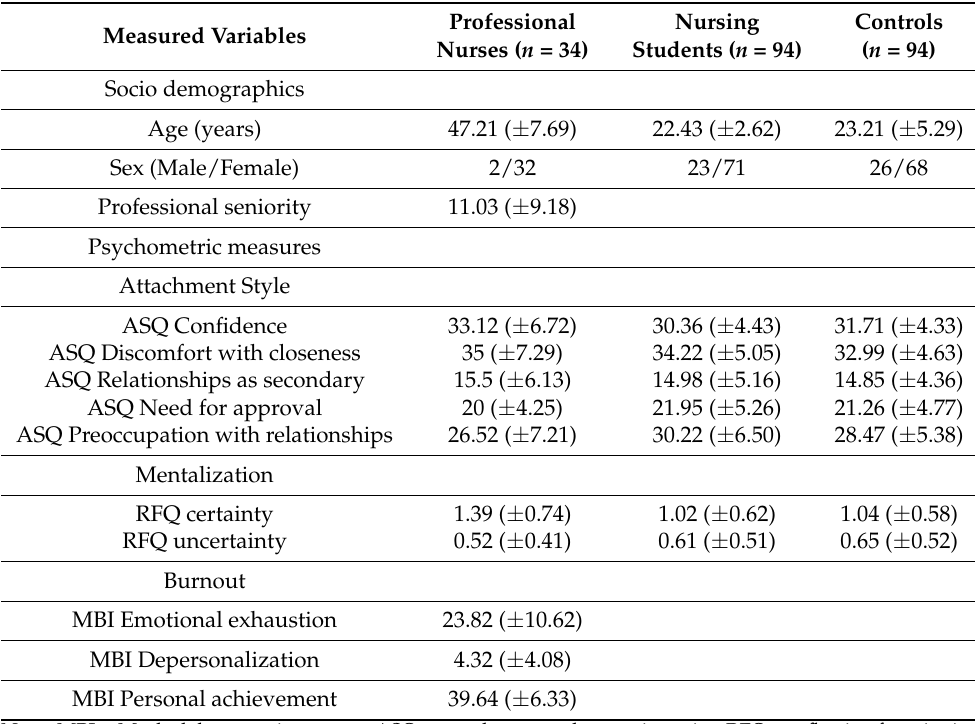
Table 1. Socio-demographic data and mean ( ± SD) scores obtained on psychometric scales are reported separately for the professional nurses, nursing students and control